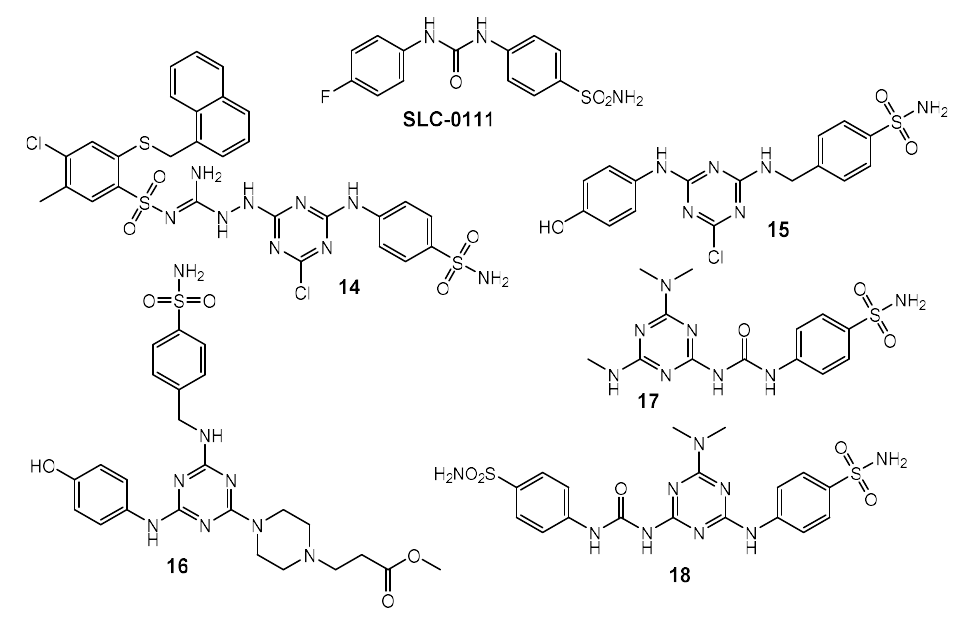
Figure 4. Structure of CA inhibitors.